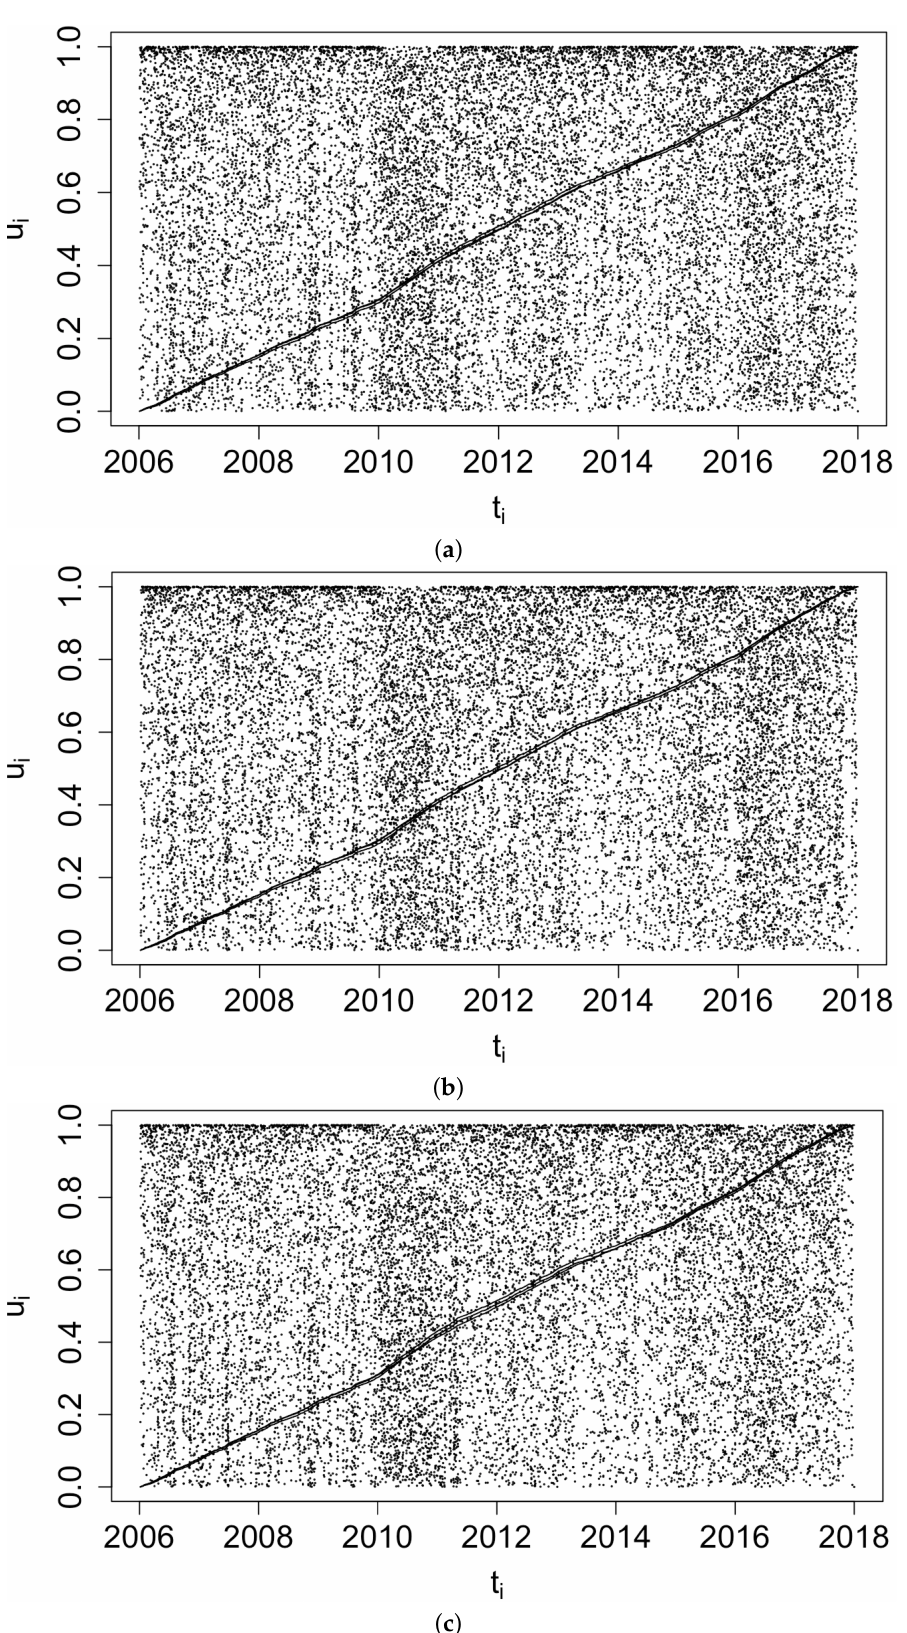
Figure 5. Superthinned residuals s i using b = 100 points/year and their corresponding standardized interevent times u i along with 95% confidence bounds, for ( a ) the Hawkes model with power law triggering, ( b ) the Hawkes model with exponential triggering, and ( c ) the recursive